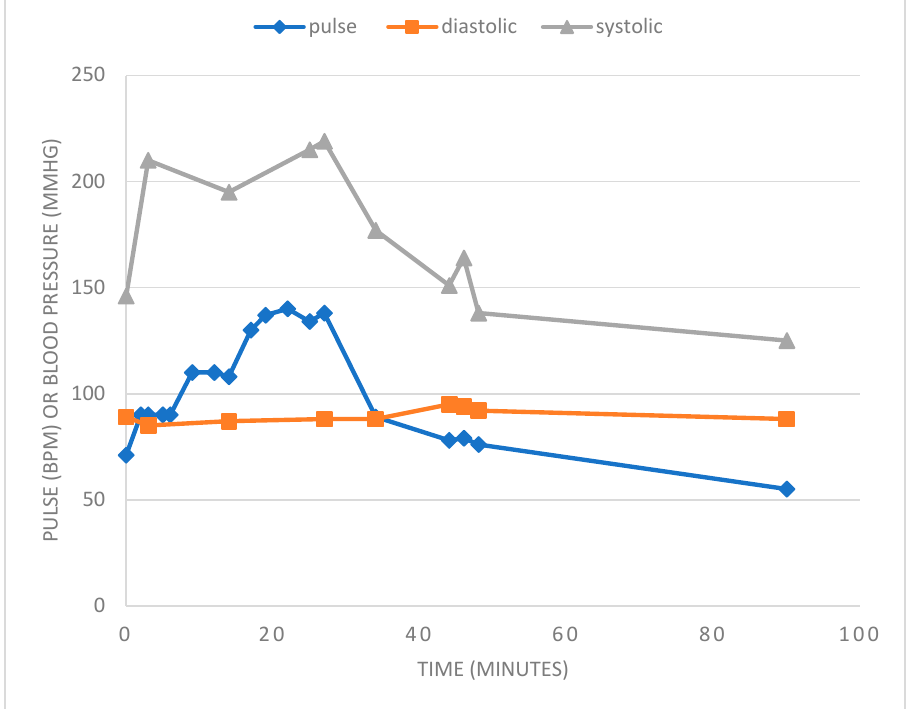
Figure 4. Blood pressure and heart rate determinations of bicycle trainer stress test.